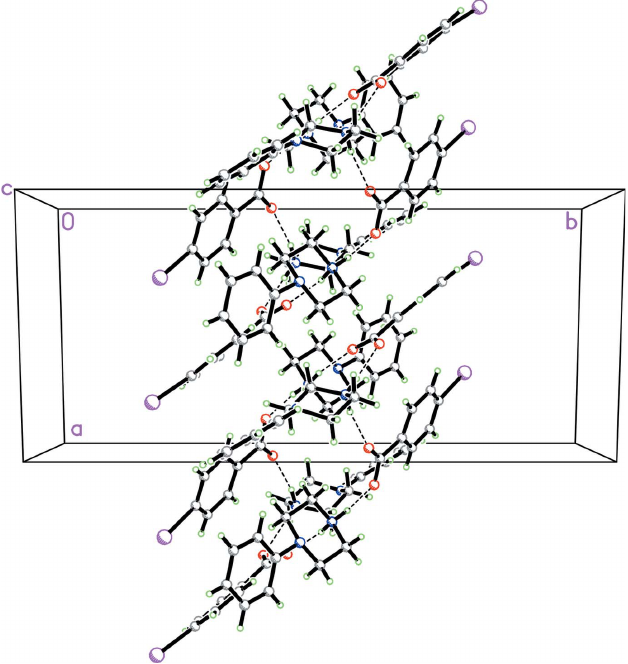
Figure 15 Packing diagram for 4 viewed along the c axis showing how the R 8 rings pack in the a -axis direction.